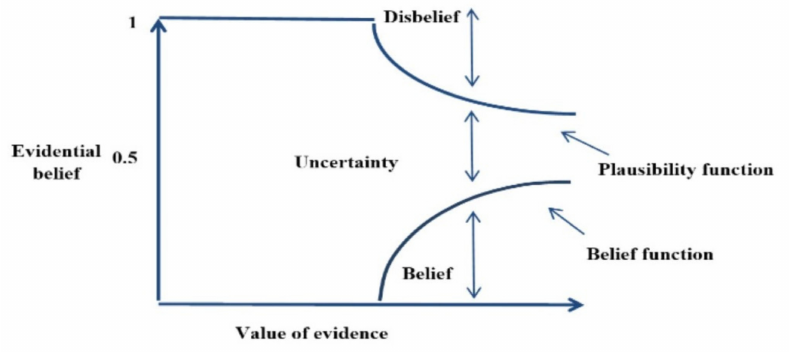
Figure 8. The general DST scheme illustrates the applied functions [61]. Reproduced with permission from Feizizadeh, Geoscience and Remote Sensing Letters; published by IEEE,